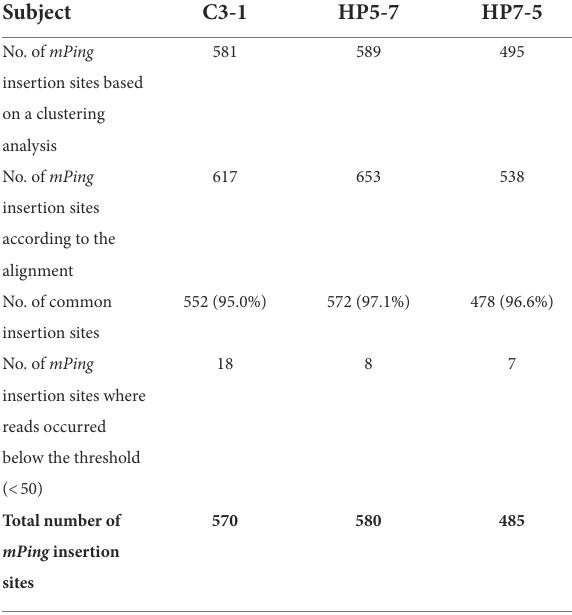
TABLE 1 The identified mPing insertion sites in the three lines of